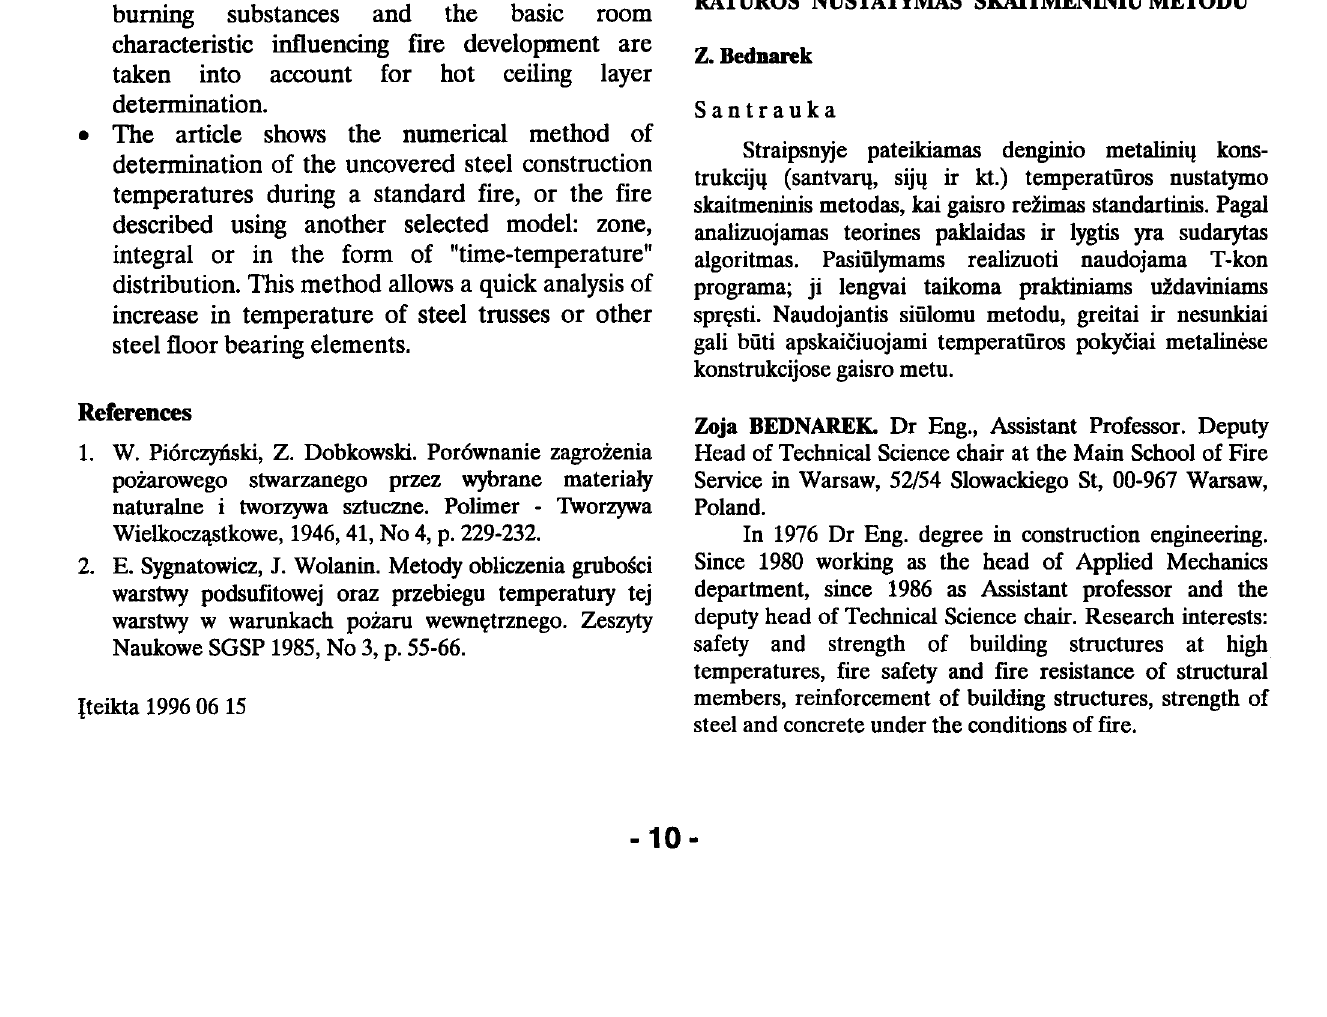
Fig. 3. Block diagram of computer program for calculating temperature of uncovered steel